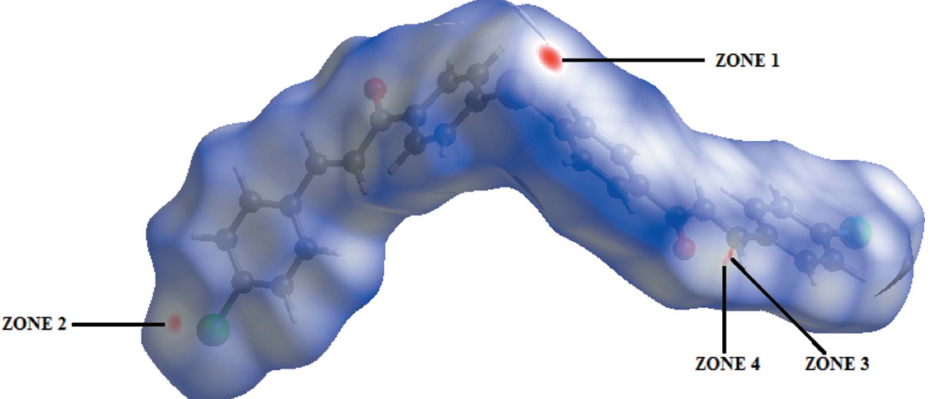
Figure 3 A view of the Hirshfeld surface mapped over d norm in the colour range (cid:5) 0.0711 to 1.3645 a.u.